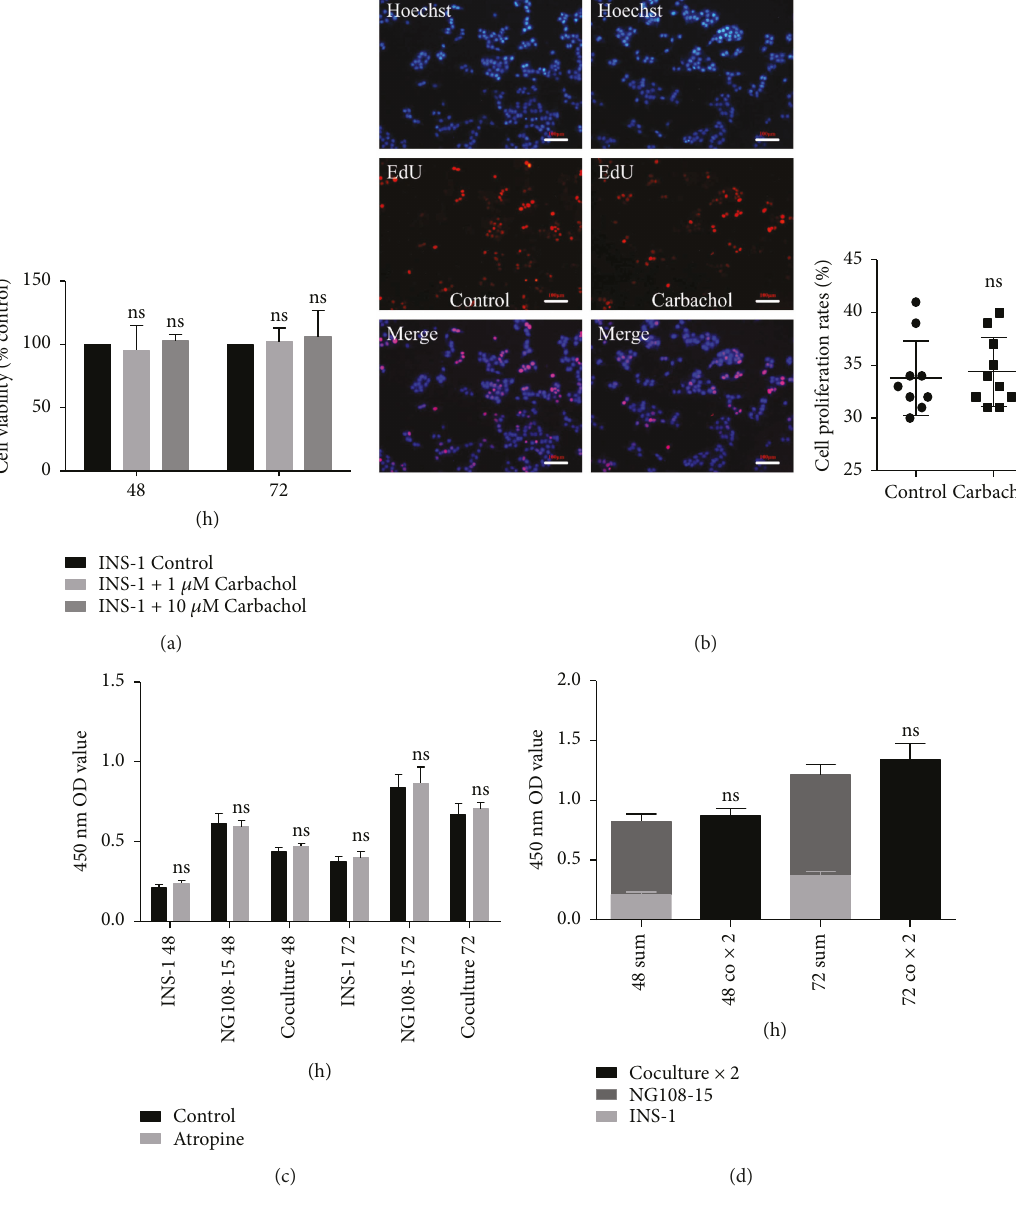
Figure 3: Coculture system hardly a ff ects proliferation of INS-1 cells. (a, c, and d) Cellular viability was determined by CCK-8 kits. Results are means ± SD of four independent experiments. (a) INS-1 cells were cultured in complete medium (control) with or without carbachol (1 μ M, 10 μ M) for 48 and 72 hours. The data were expressed as percentages of untreated control cells and ns versus INS-1 control group, n = 4 . (b) INS-1 cells were cultured in complete medium (control) with or without 10 μ M carbachol for 72 hours. EdU-labeled INS-1 cells were assessed using fl uorescent microscopy. All cell nuclei were Hoechst 33342-positive (blue), and all replicating cells were EdU-positive (red). The scatter plot represents the percentage of EdU-labeled proliferative INS-1 cells. Data were presented as the mean ± SD. ns versus control group, n = 10 . (c) Cells were cultured in coculture medium (control) with or without 10 μ M atropine sulfate for 48 and 72 hours. The data were expressed as 450nm OD value and ns versus control group, n = 4 . (d) Cells were cultured in coculture medium for 48 and 72 hours. The data were expressed as 450 nm OD value and ns versus the sum of INS-1 group and NG108-15 group, n = 4